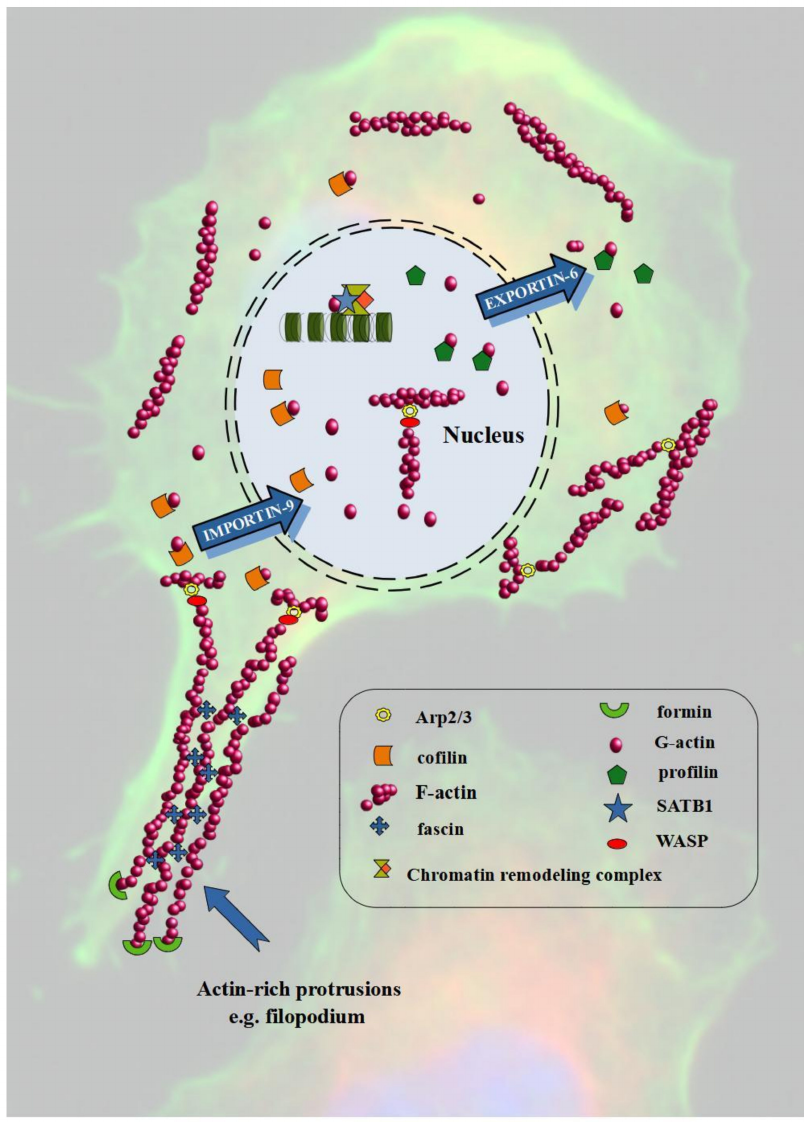
Figure 3. Actin and ABPs in cancer cells invasion and migration. Modified on the basis of Winder and Ayscough (2005) and Hurst et al. (2019)